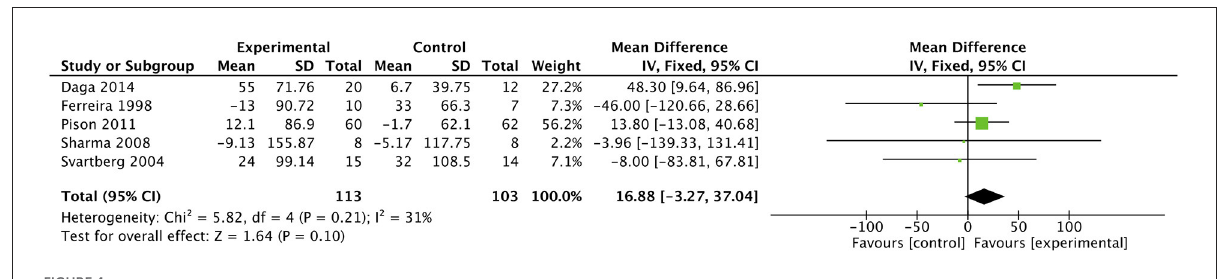
FIGURE4 Forest plots of meta-analysis of 6-min walking